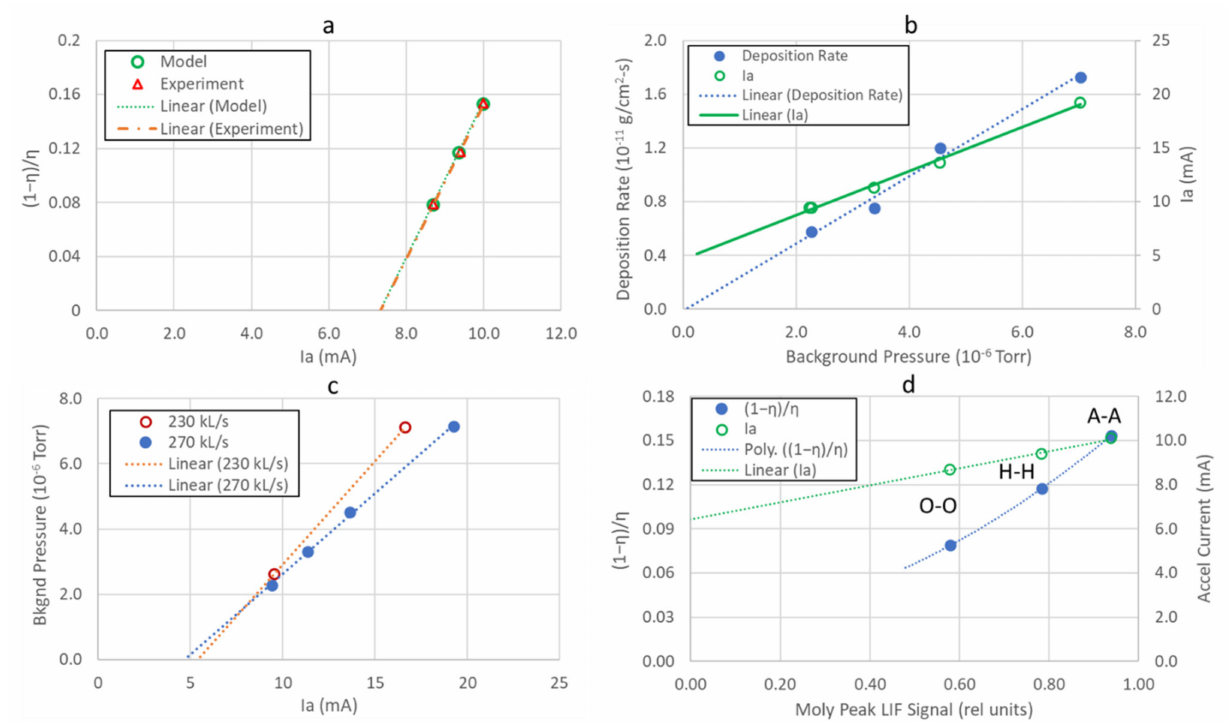
Figure 8. DTL28 parameter variations. ( a ) Dependence of accel current on the (1 − η )/ η function; ( b ) QCM signal dependence on background pressure near peak of DTL28-H-H deposition rate profile; ( c ) accel current variation with background pressure; and ( d ) molybdenum peak LIF signal variation with accel current and (1 − η )/ η at grid